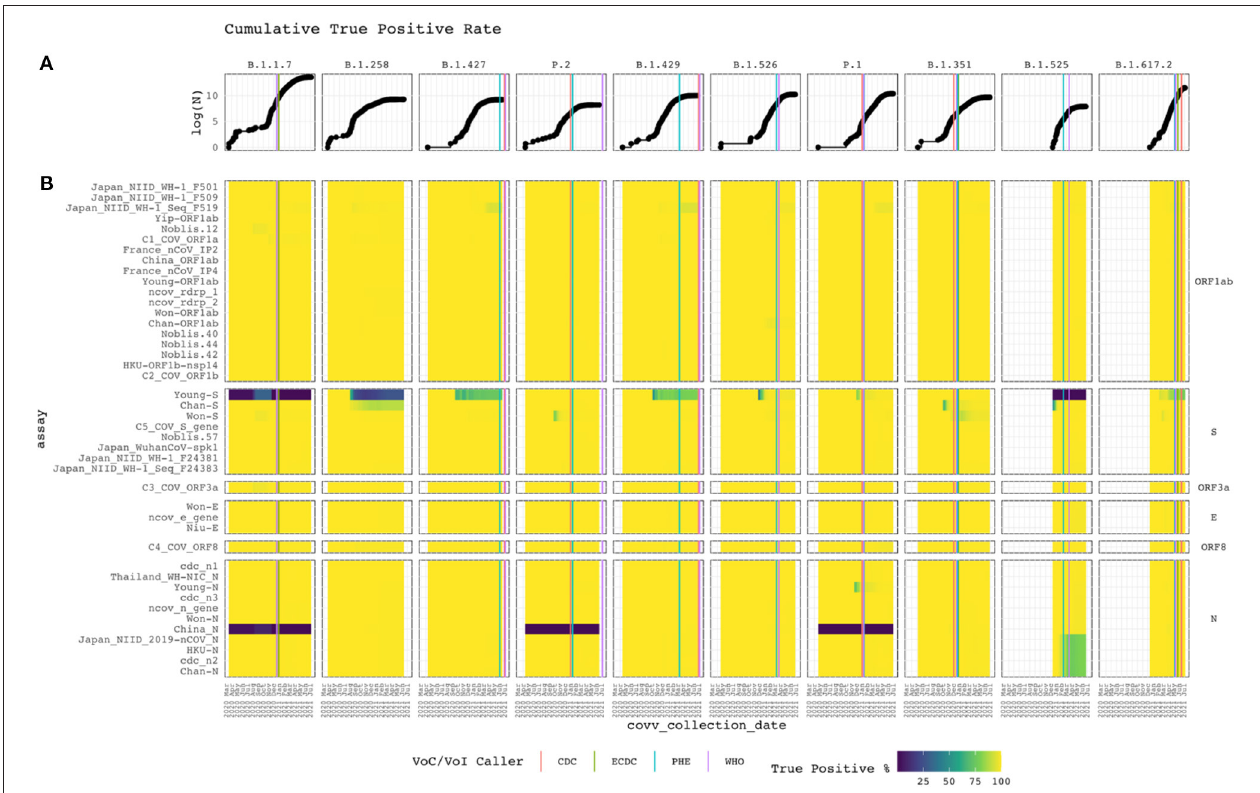
FIGURE 4 | Cumulative true positive rate. Vertical and horizontal facets divide the graph by Pango lineage and assay target gene. (A) The top line graph shows the logarithm of the cumulative total of subject sequences. (B) Heat map of the current PCR assays with the cumulative conditional true positive rate assessed from Apr 2020 to Feb 2021. The assay targeting specific genes are labeled on the right. White represents the absence of subject sequences of the lineage in the reference database. Vertical lines when each disease control organization called the lineage a VoC/VoI based on available data (compiled in Supplementary Table A